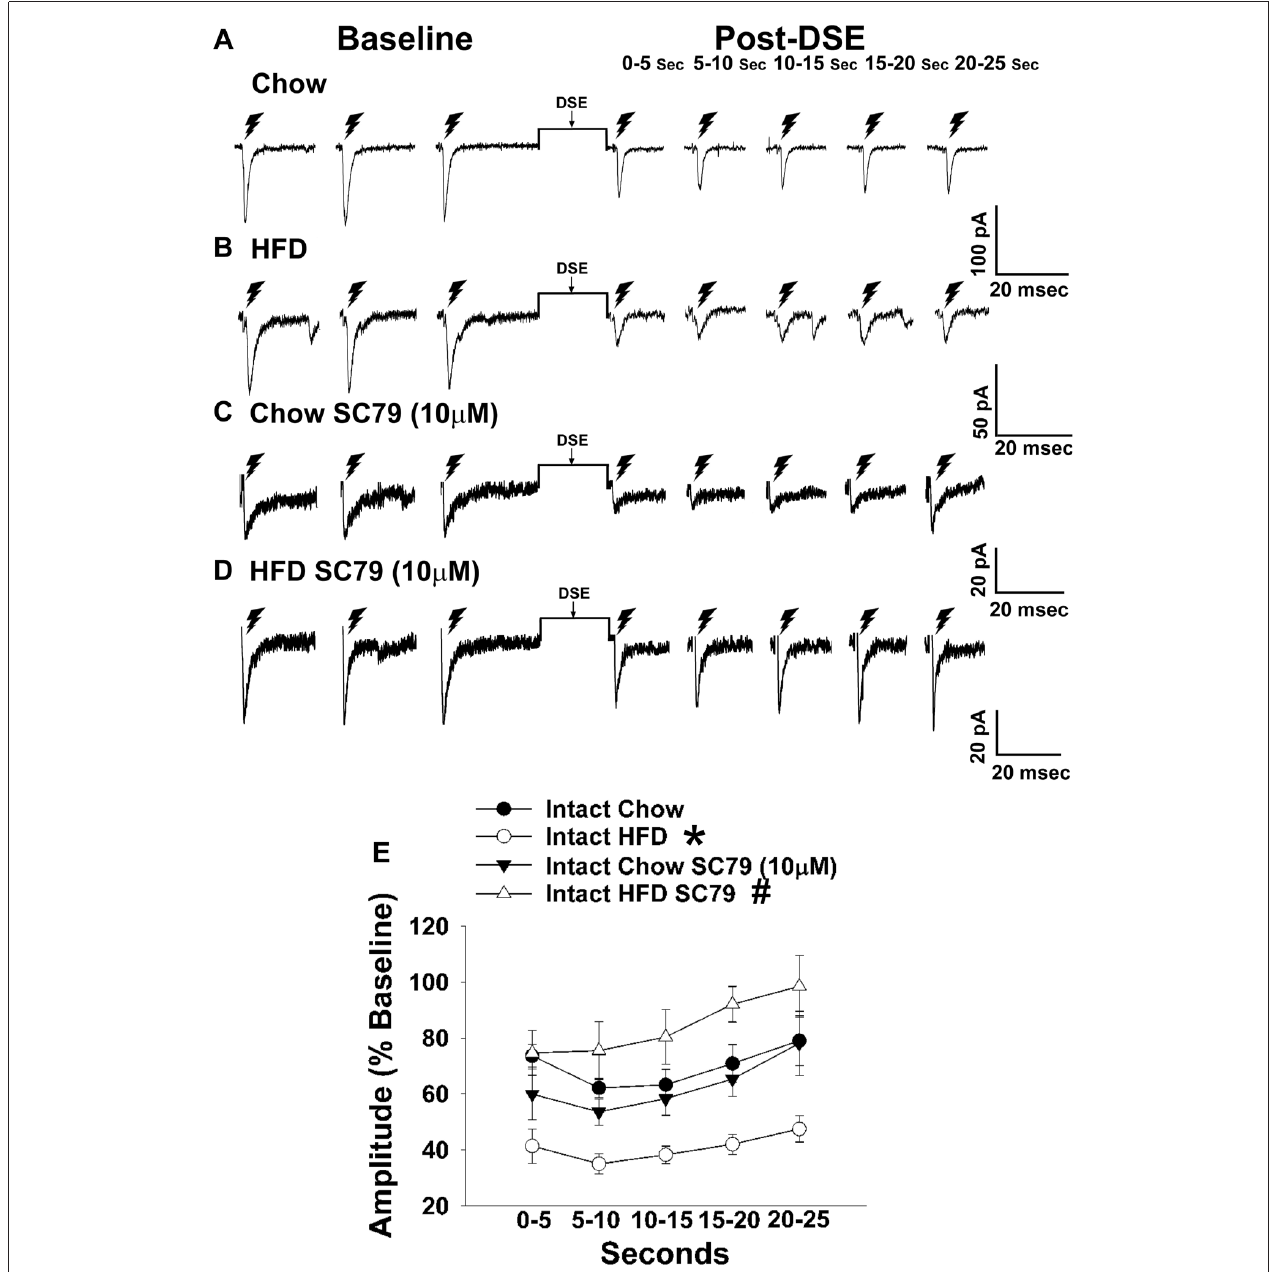
FIGURE 5 | HFD intensifies the reduction in eEPSC amplitude caused by postsynaptic depolarization, which is abrogated by Akt activation. The reduction in eEPSC amplitude caused by the DSE seen in chow-fed animals ( A ; n = 9) is further amplified in HFD-fed animals ( B ; n = 5). The reduction in eEPSC amplitude caused by postsynaptic depolarization seen during recordings in slices taken from chow-fed animals is unaffected by pretreatment with the Akt activator SC79 (10 µ M; C ; n = 6). However, the heightened retrograde signaling observed in slices from HFD-fed animals (B) was completely abolished with SC79 ( D ; n = 5). The composite line graph further illustrates the heightened postsynaptic depolarization-induced reduction in eEPSC amplitude caused by the HFD, and the impact of reduced PI3K/Akt signaling on the augmented EC tone (E) . Lines represent means and vertical lines 1 SEM. ∗ P < 0.05 relative to chow-fed animals; rank-transformed multifactorial ANOVA/LSD. # P < 0.05 relative to vehicle-treated slices; rank-transformed multifactorial